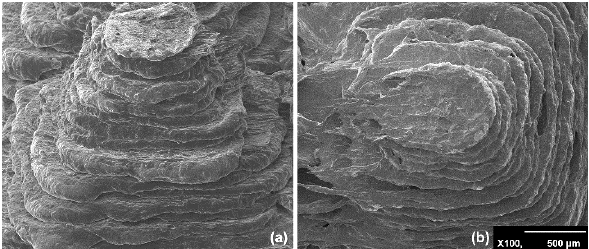
Figure 1. Typical SEM photographs of the ZnO/three-dimensional (3D)-printed graphene pyramids: ( a ) side view; ( b ) top view.